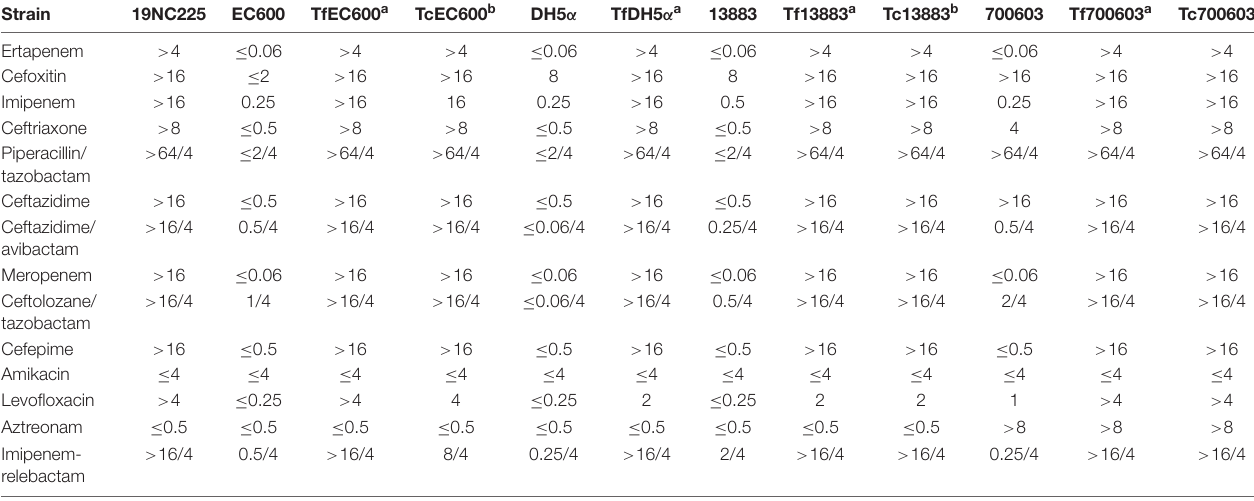
TABLE 1 | MIC of the clinical strain, donors, and recipients with/without pNC225/NDM-29.